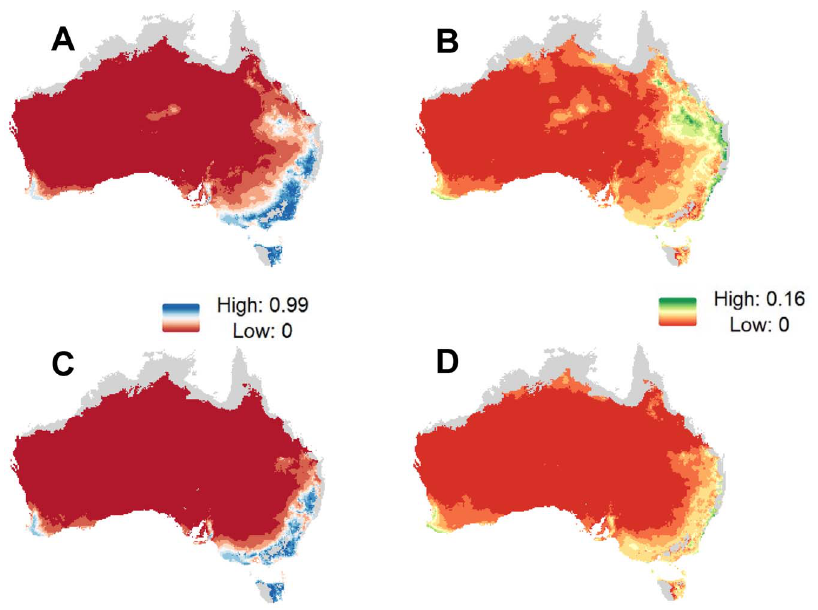
Fig. 2. Predicted RCV-A1 prevalence in Australia and associated standard error for wet and dry periods. (A) and (B) RCV-A1 prevalence and standard error for an episode of above average rainfall from 2010 to 2012 (Wet Period). (C) and (D) RCV-A1 prevalence and standard error for an episode of below average rainfall from 2002 to 2004 (Dry Period). Areas in grey represent novel climate conditions, where predictions could not be